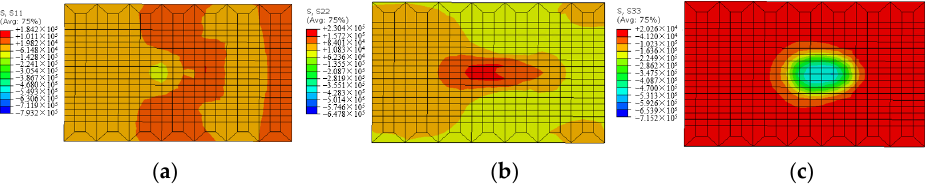
Figure 12. The cloud of the dynamic stresses of ART pavement at the speed of 10 km/h. ( a ) Longitudinal. ( b ) Transvese. ( c ) Vertical.